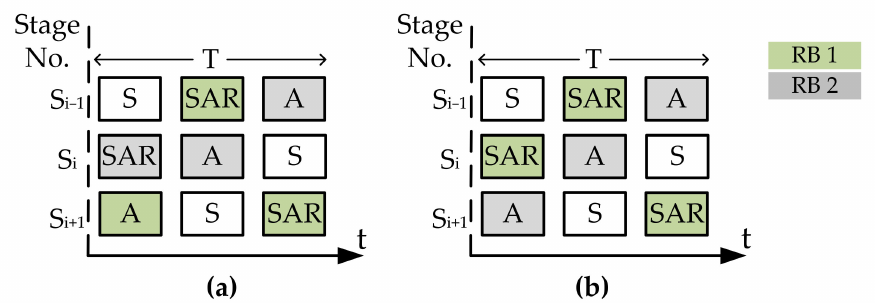
Figure 5. Two possible implements of the reference sharing scheme. The connection differs in the S i and S i+1 where ( a ) references not exchanged and ( b ) references exchanged with each